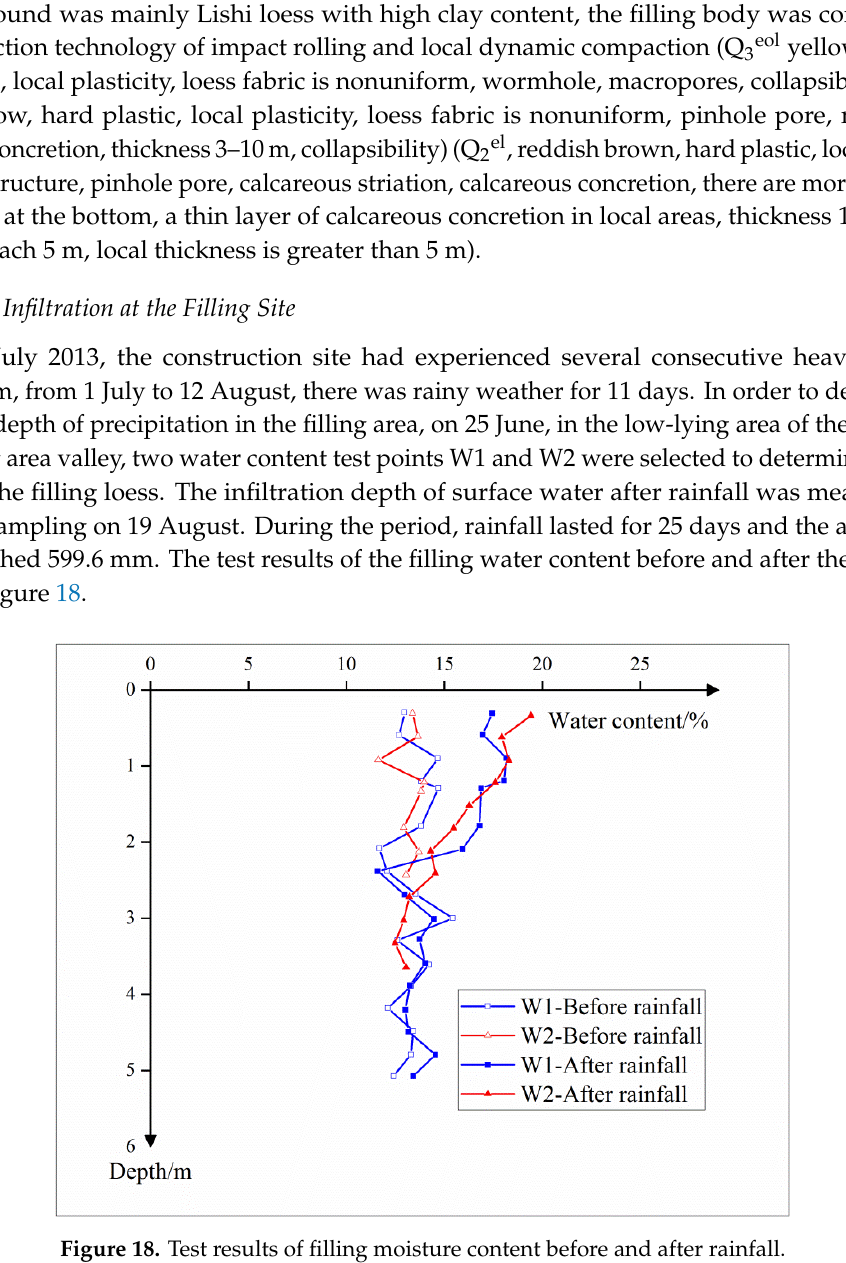
Figure 18. Test results of filling moisture content before and after rainfall.